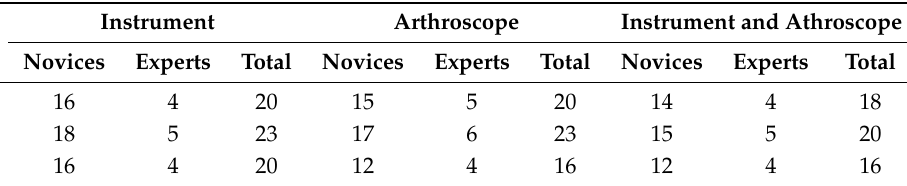
Table 1. Number of subjects with valid data from the instrument, the arthroscope, and both the instrument and the arthroscope for the three studied tasks.